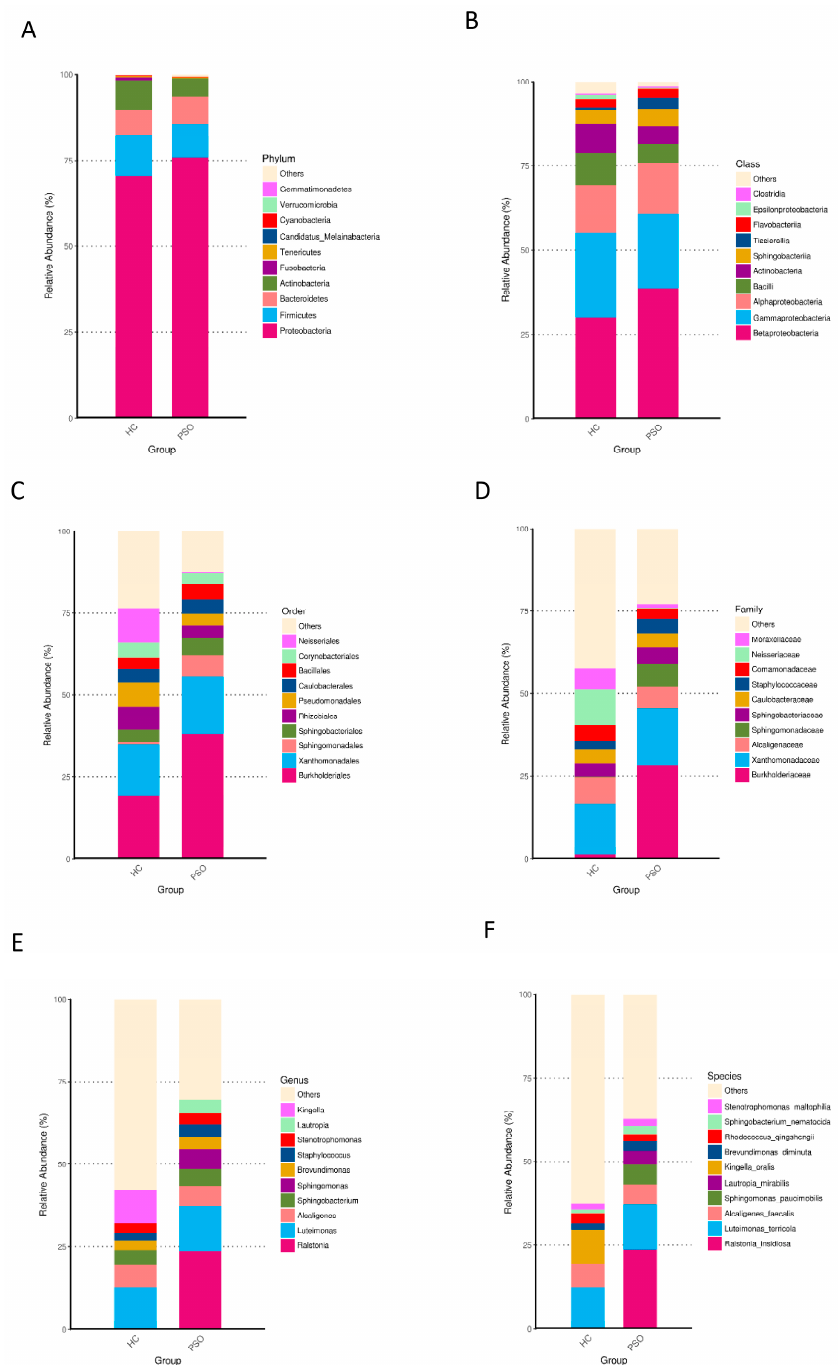
Figure 4. Relative abundance distribution of the top 10 species in phylum ( A ), class ( B ), order ( C ), family ( D ), genus ( E ), and species ( F ) in the two groups (HC: healthy control group; PSO: psoriasis